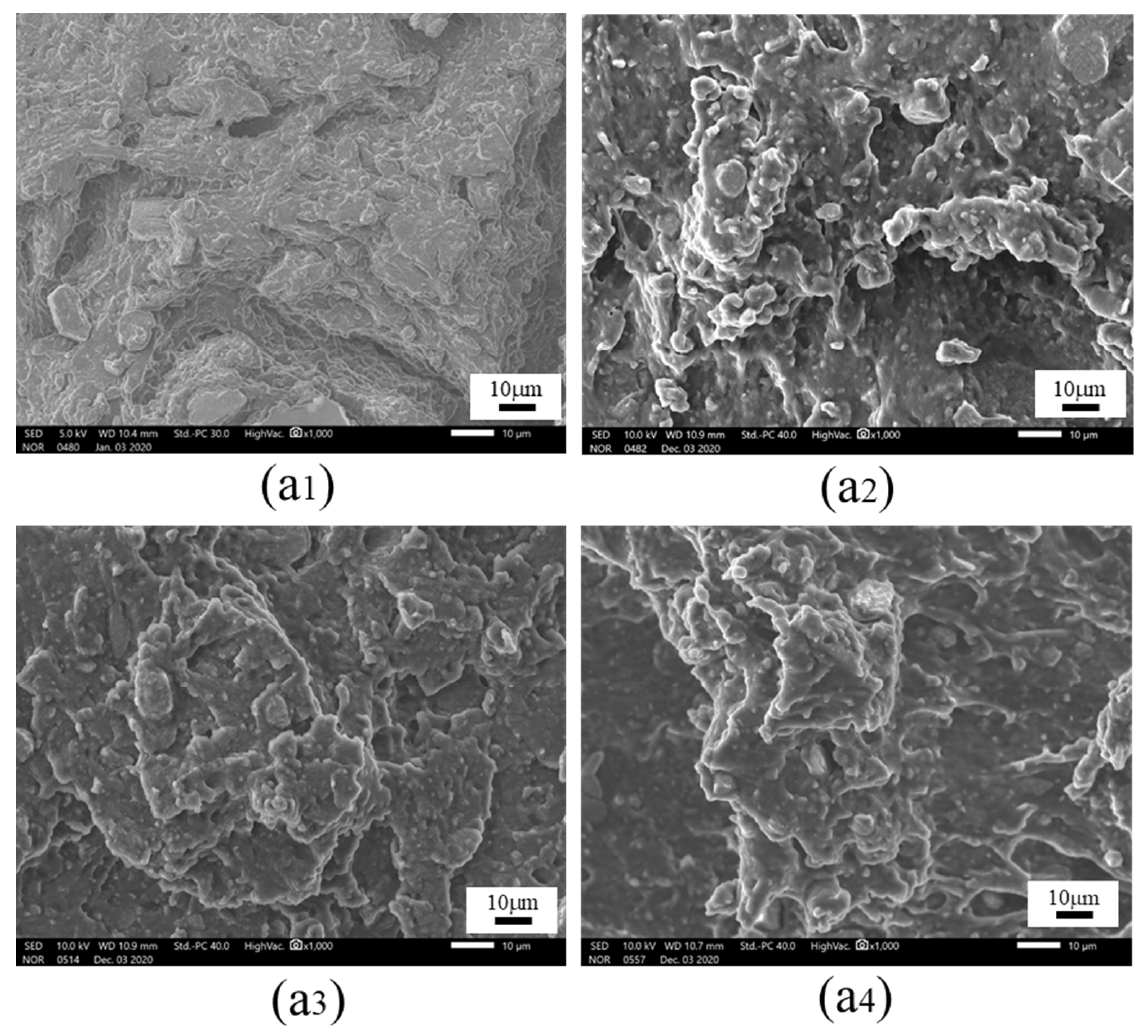
Figure 12. SEM of failure section: loading ( a1 ) 0 N, ( a2 ) 200 N, ( a3 ) 400 N and ( a4 ) 600 N under HT environment.